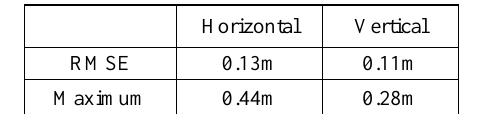
Figure 14. Area of comparison